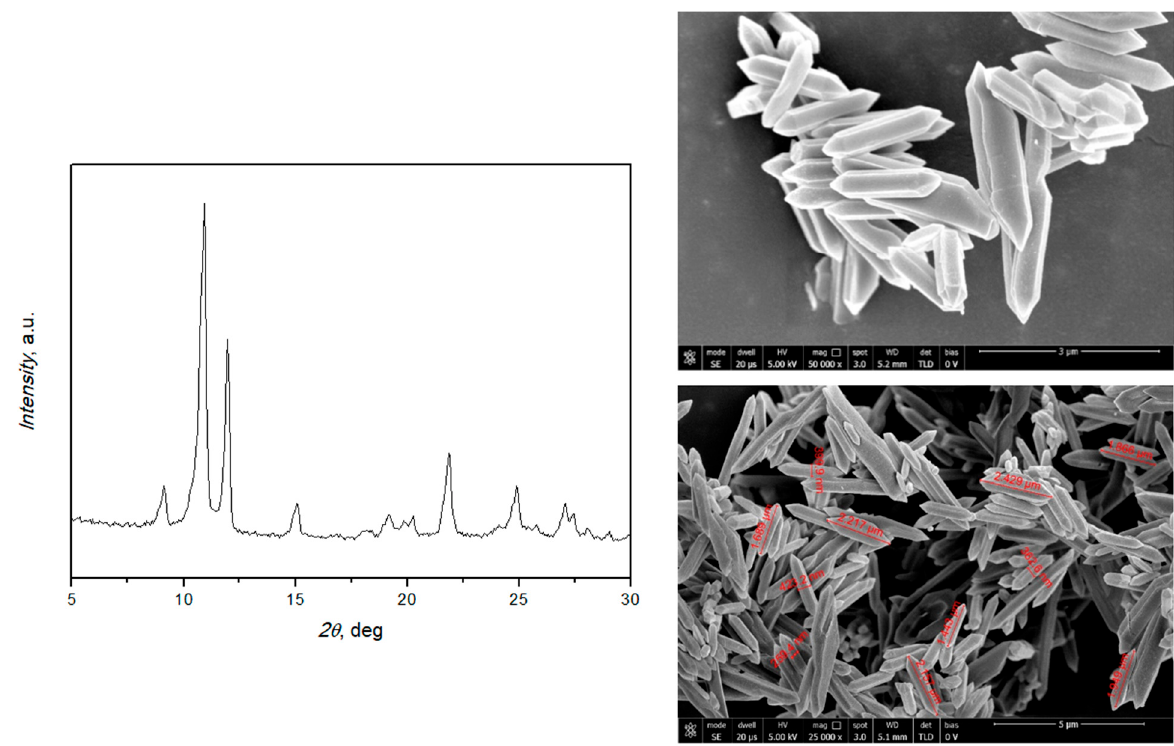
Figure 1. XRD pattern and SEM images of MIL-88A.